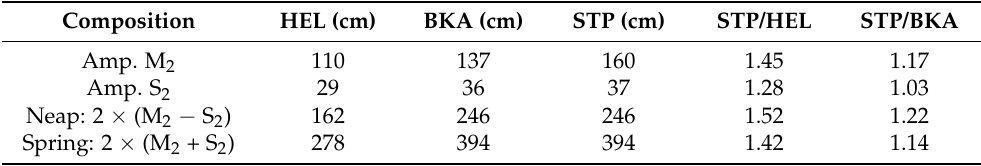
Figure 8. Relationship between the ratio of tidal range in the port of Hamburg at St. Pauli (STP) and the offshore gauge at Helgoland island (HEL) in the German Bight plotted against the tidal range of the respective tide at Helgoland for the hydrological years 2000 to 2019. Table 2. M 2 and S 2 amplitudes as well as spring and neap tidal range resulting from M 2 and S 2 interference for gauges Helgoland (HEL), beacon A (BKA) and St. Pauli (STP) as well as amplification ratios between STP and the other two